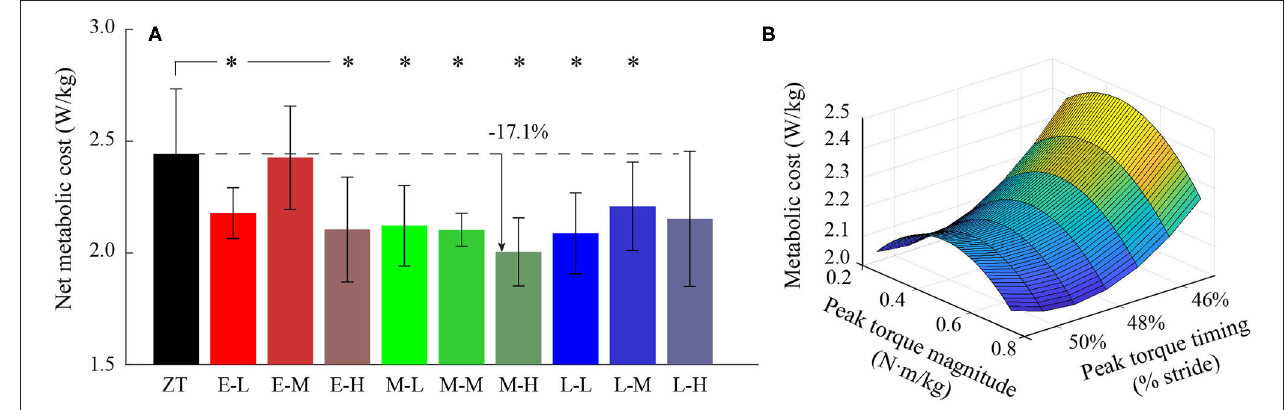
FIGURE 7 | (A) Net metabolic cost in the ZT condition and nine assistance conditions. (B) Two-dimensional regression result for the relationship between peak torque timing, peak torque magnitude, and net metabolic cost. *represents statistically significant differences with respect to the ZT condition.